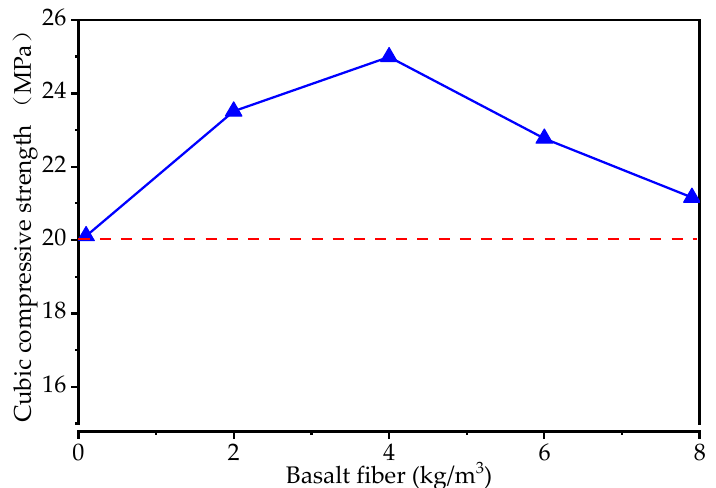
Figure 3. The cubic compressive strength of the specimens with different levels of basalt fiber content.